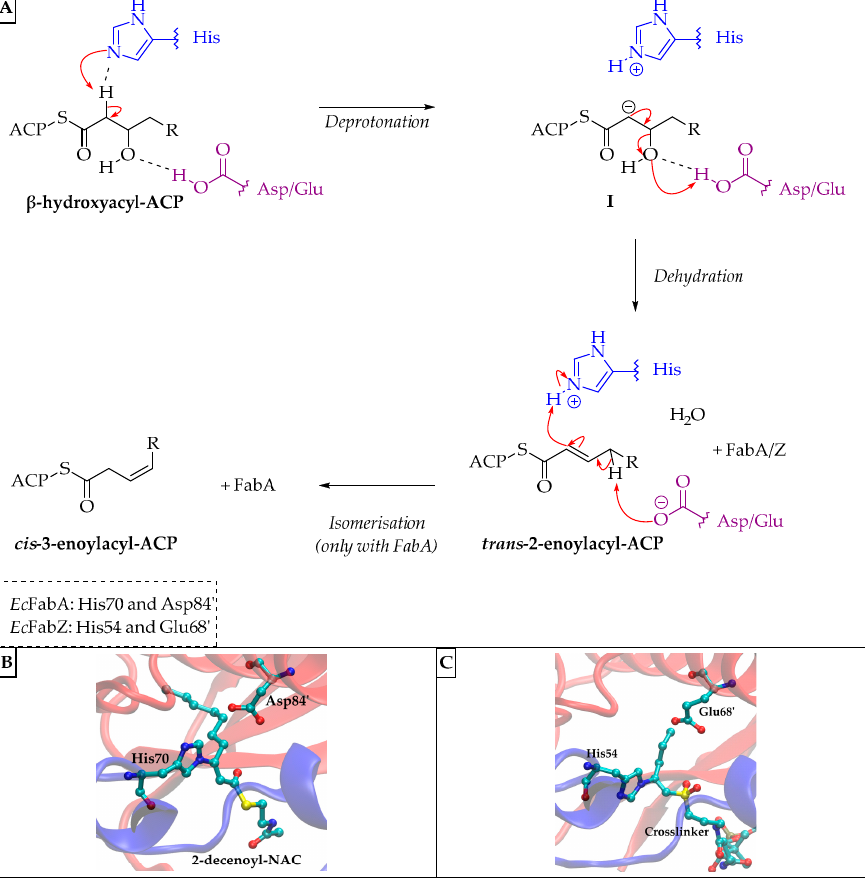
Figure 21. ( A ) Scheme of the mechanism of the reactions catalysed by Ec FabA and Ec FabZ. ( B ) View of the active site of Ec FabA (PDB ID 1MKA) in complex with 2-decenoyl- N -acetylcysteamine (NAC). The catalytic His70 is covalently bonded to 2-decenoyl-NAC. ( C ) View of the active site of Ec FabZ in complex with a cross-linker simulating intermediate I (PDB ID 6N3P).